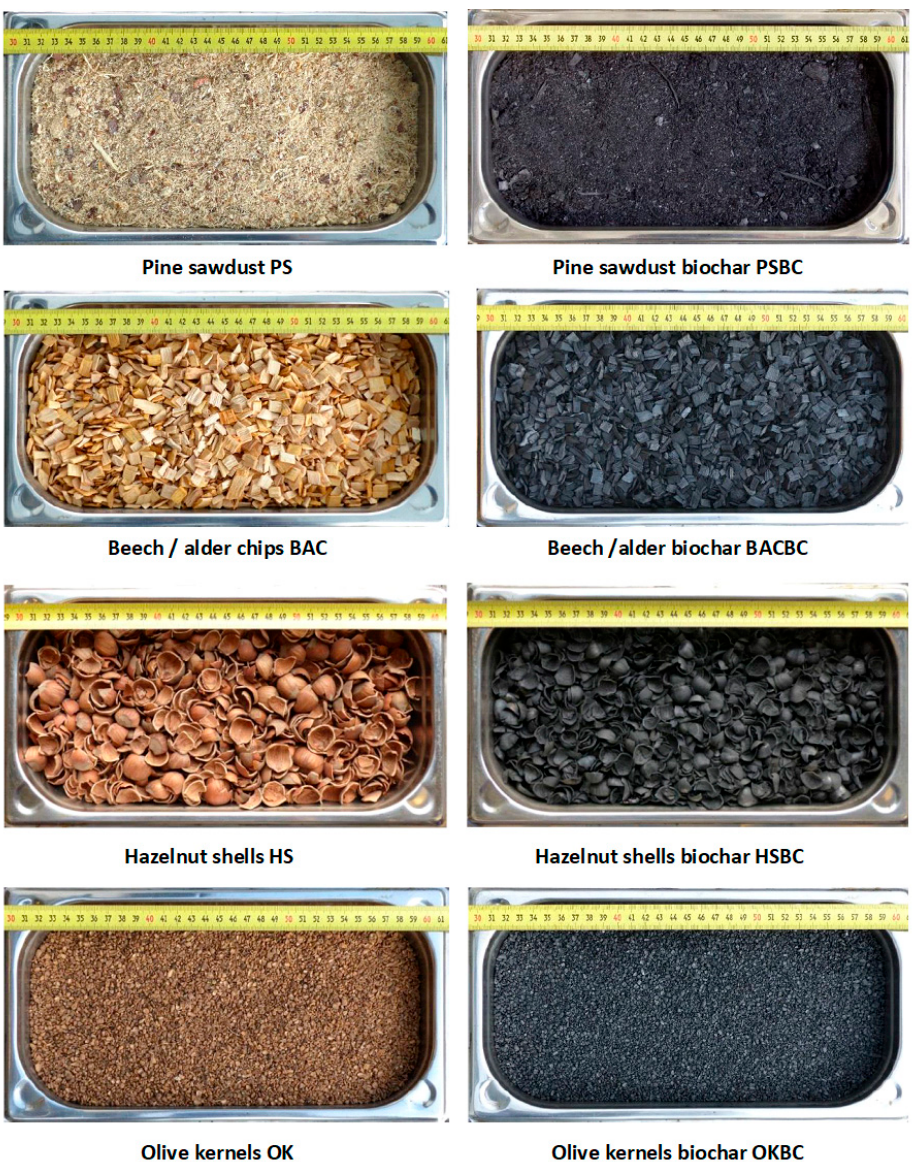
Figure 2. Raw biomass samples and produced